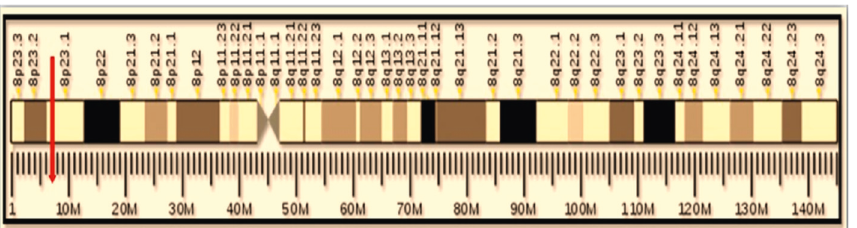
Figure 3: DEFA4 cytogenetic location in the human genome (8p23.1.), DEFA4 gene is therein located on the short arm (p) of chromosome 8 at position 2, band 3, sub-band